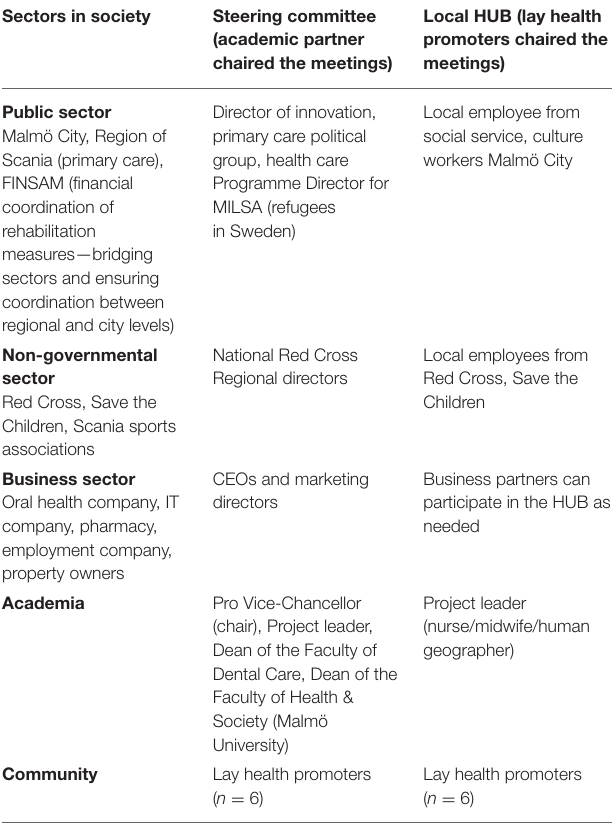
TABLE 1 | Overview of management structure (only listing key actors most relevant to the lay health promoters’ work). Sectors in